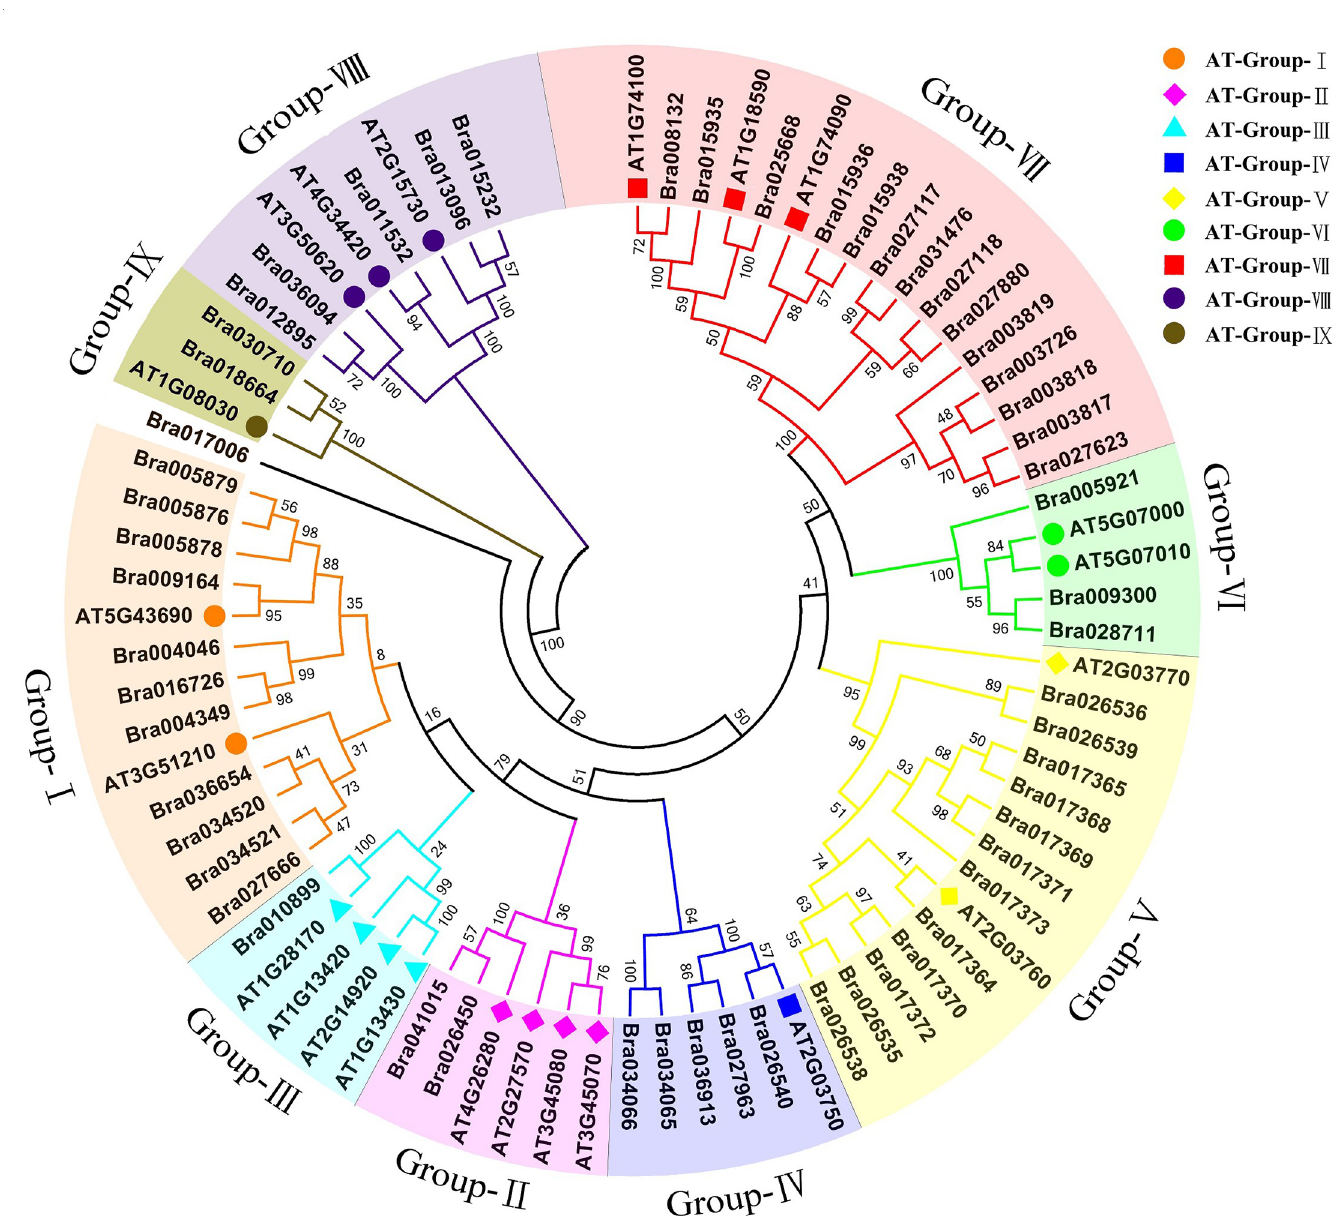
Fig 2. Phylogenetic tree of sulfotransferase (SOT)-domain proteins in Arabidopsis thaliana and Brassica rapa . The tree includes 56 BraSOT and 22 AtSOT proteins. Values above and below branches are bootstrap percentages based on 1000 replicates. AtSOT proteins are indicated by colored symbols corresponding to SOT groups I to